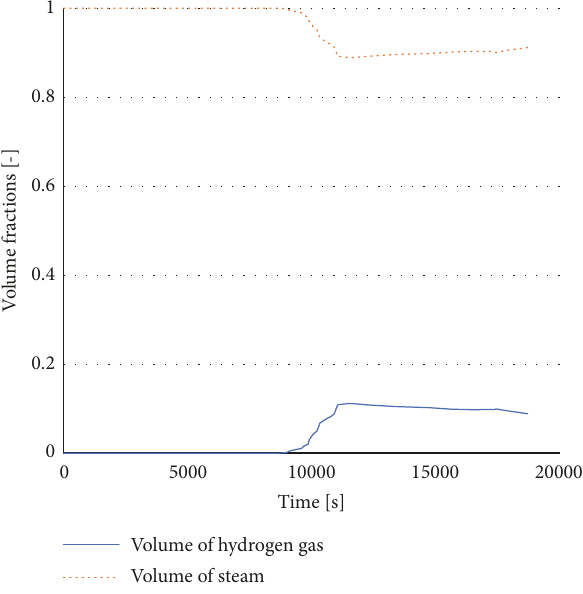
the aerosol phase, reactor was shut down. Gas temperature and pressure in containment vessel reduce to 381 K and 2.0 bar, respectively.